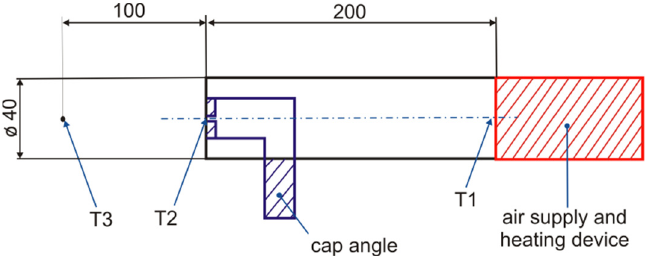
Figure 3. Temperature measurement locations. The dimensions are given in millimeters. Table 2. Measured temperature values.